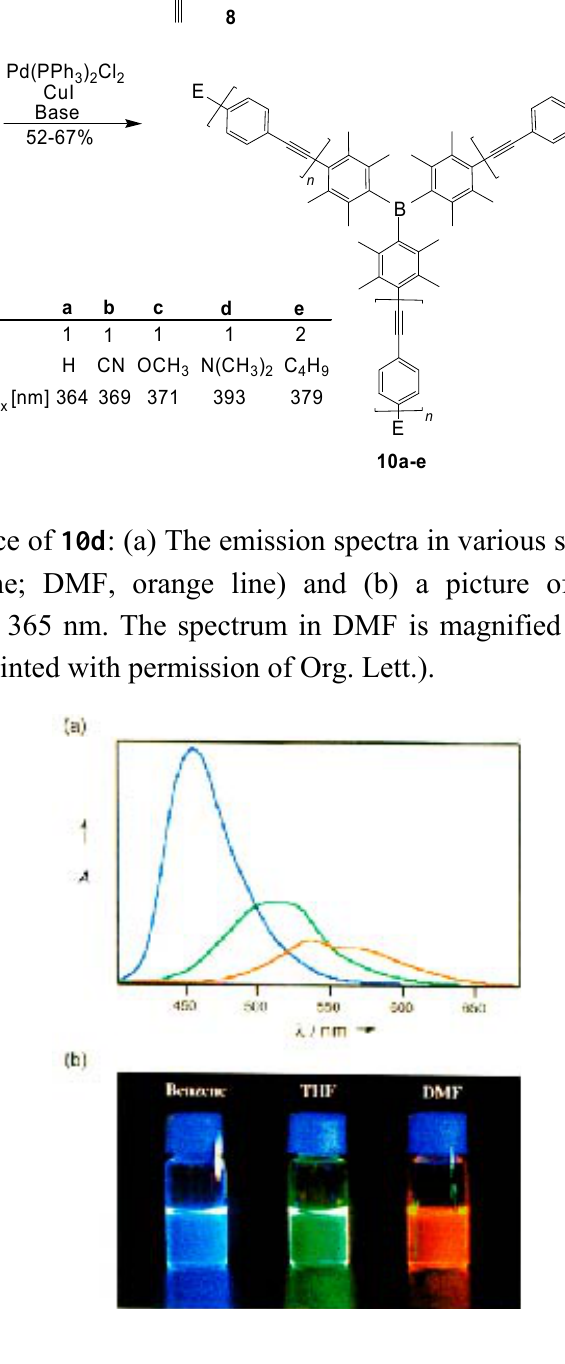
benzene changes to green (  = 512 nm) in THF, and to orange (  max The fluorescence quantum yields of 10a-e in THF range between  Scheme 3. Preparation of the triarylboranes ( 10a-e ) with extended conjugation. Absorption maxima in THF.